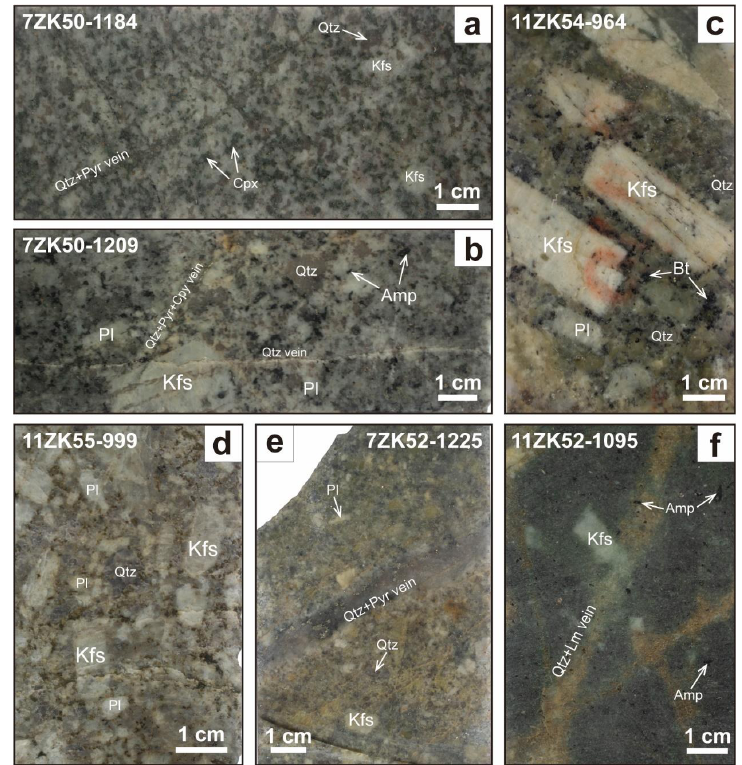
Figure 3. Photographs of the granite porphyry samples collected from the drill holes in the Hongniu- Hongshan deposit. The sampling positions are marked in Figure 2b,c. Large K-feldspar phenocrysts in granite porphyry samples are mostly euhedral and widely dis-tributed ( a – f ). Quartz grains are anhedral in the phenocrysts ( a – e ). Plagioclase grains are smaller than K-feldspar in the phenocrysts ( b – e ). Clinopyroxene, amphibole, and biotite are commonly small and occurred in both phenocryst and matrix ( a – c , f ). Hydrothermal veins in these porphyries are usually composed of quartz ( b ), quartz + pyrite ( a , e ), quartz + pyrite + chalcopyrite ( b ), and quartz + limonite ( f ). Kfs = K-feldspar, Pl = plagioclase, Qtz = quartz, Cpx = clinopyroxene, Amp = amphibole, Bt = biotite, Pyr = pyrite, Cpy = chalcopyrite, Lm = limonite.